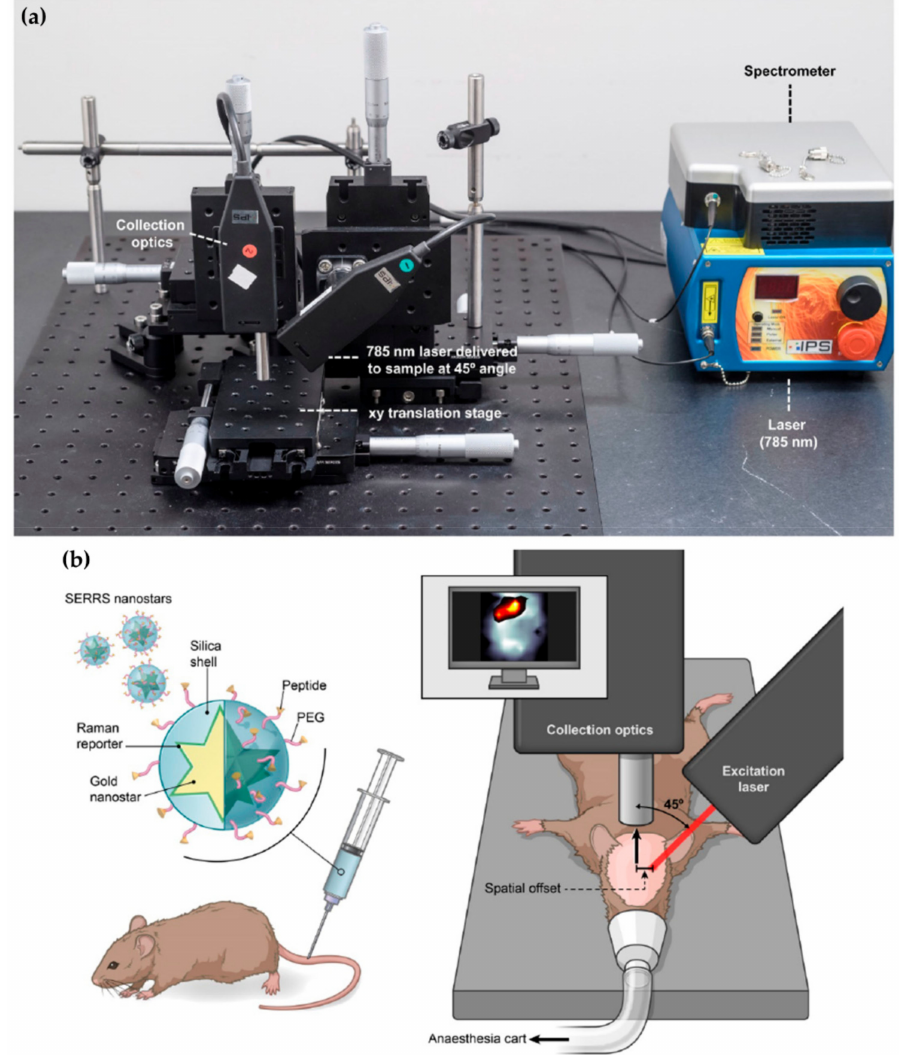
Figure 3. ( a ) SORS setup used by Nicolson et al. in the study of glioblastoma multiforme tumours; ( b ) conceptual scheme outlining the integrin-based detection of GBM through the use of cRGDyK- conjugated SERRS nanostars and in vivo SESORRS imaging of GBM performed in a custom-built SORS system depicted in ( a )